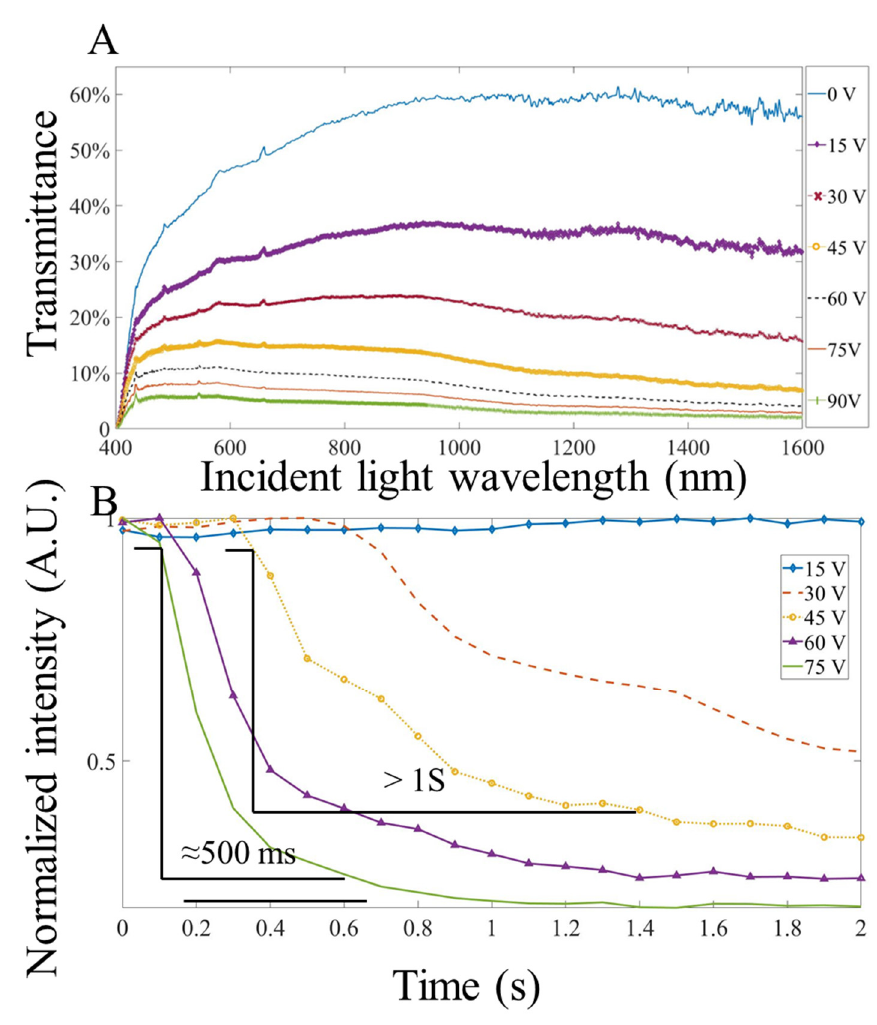
Figure 4. ( A ). The transmittance of the NLC at different wavelengths from 0 to 90 V. ( B ). Response time at different activation voltage (estimated at 560 nm wavelength) .